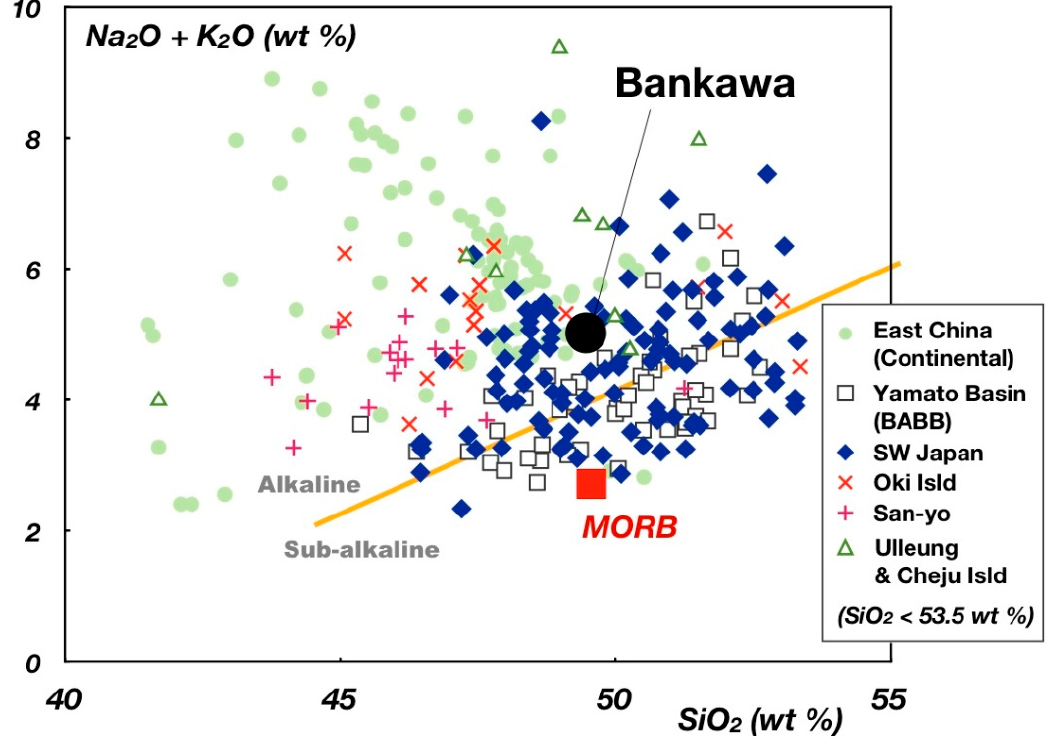
Figure 4. SiO 2 vs. total alkali (Na 2 O + K 2 O) of the host alkali basalt. The solid yellow line is the boundary between alkali- and subalkali-basalts of Miyashiro [50]. Reference data are selected alkali basalts (SiO 2 < 53.5 wt %) from SW Japan, east China, and back-arc basin basalts from Yamato basin, the Sea of Japan. Data source; SW Japan, Oki Island and San-yo [51–56]: Ulleung and Cheju Islands [51,52,57]: East China [51,58–61]: Yamato Basin (ODP Leg 127/128, Sea of Japan) [62,63]. The Bankawa alkali basalt hosting the xenoliths is very similar in trace-element (primitive mantle normalized) and REE (chondrite-normalized) patterns to the Cenozoic alkali basalts from the SW Japan arc, some of which contain mantle peridotite xenoliths [64] (Figure 5). The patterns are simple, being almost monotonously declining from more incompatible element to less incompatible one (Figure 5), although it shows slight troughs at Zr, Hf and